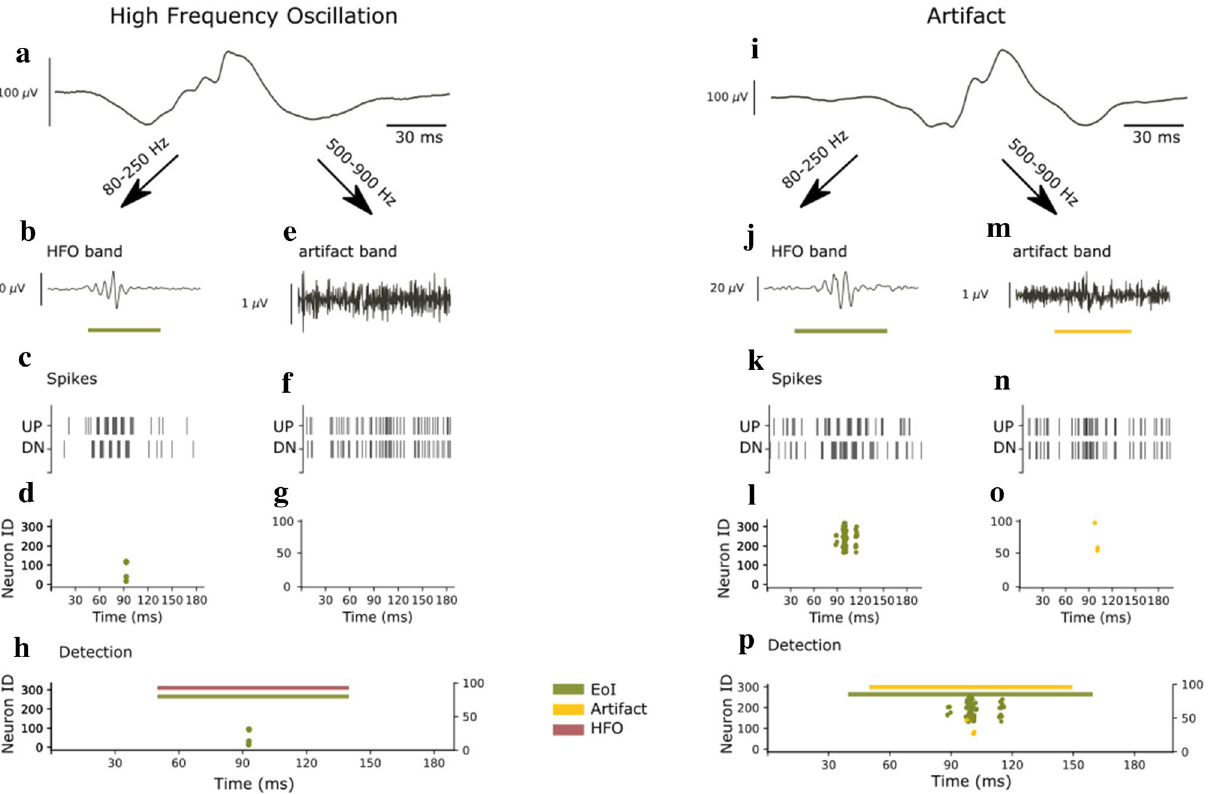
Figure 2. Example of a detected HFO and an artifact. The EEG SNN can distinguish if an EoI in the EEG is an HFO or an artifact. ( a , i ) EEG signal as recorded. ( b , j ) EEG signal filtered in the ripple band (80–250 Hz). ( e , m ) EEG signal filtered in the 500–900 Hz band. ( c , k ) Input spike trains to the core SNN. ( f , n ) Input spike trains to the artifact detection SNN. ( d , l ) Raster plot of the neurons in the second layer of the core SNN. ( g , o ) Raster plot of the neurons in the second layer of the artifact detection SNN. ( h , p ) Comparison of EoI and artifact marks. For the EEG signal on the left ( a ), the core SNN indicates an EoI by eliciting spikes ( d ). The absence of activity from the artifact detection SNN (no spikes in g) indicates that no artifact occurred at this time. ( h ) The EEG SNN classifies this EoI as HFO. The EEG signal on the right ( i ) elicits spikes in the core SNN, which indicate an EoI ( l ). The activity from the neurons in the artifact detection SNN ( o ) indicates that an artifact occurred at this time. ( p ) The EEG SNN marks this EoI as an